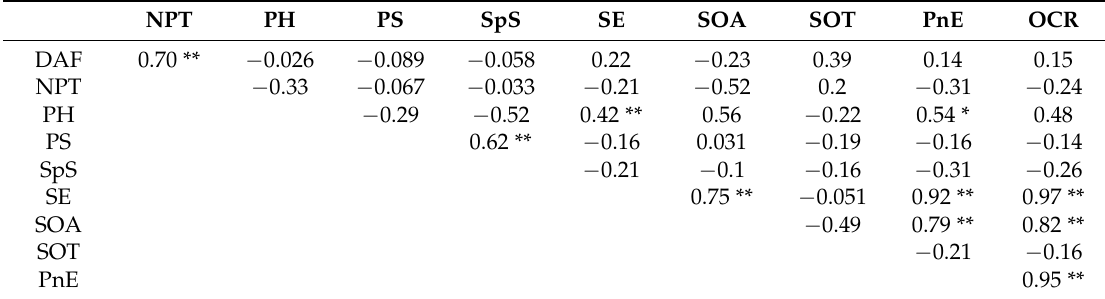
Table 6. Correlation coefficients between agronomic and floral characteristics in 17 CMS